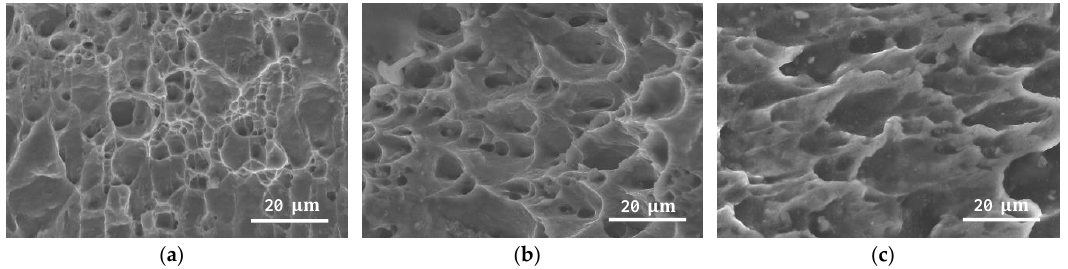
Figure 6. Scanning electron microscope (SEM) of the fracture surface of aluminium AA1050-H111 obtained from ( a ) DNTT ( b ) staggered DNTT with α = 80 ◦ and ( c ) shear test specimens.